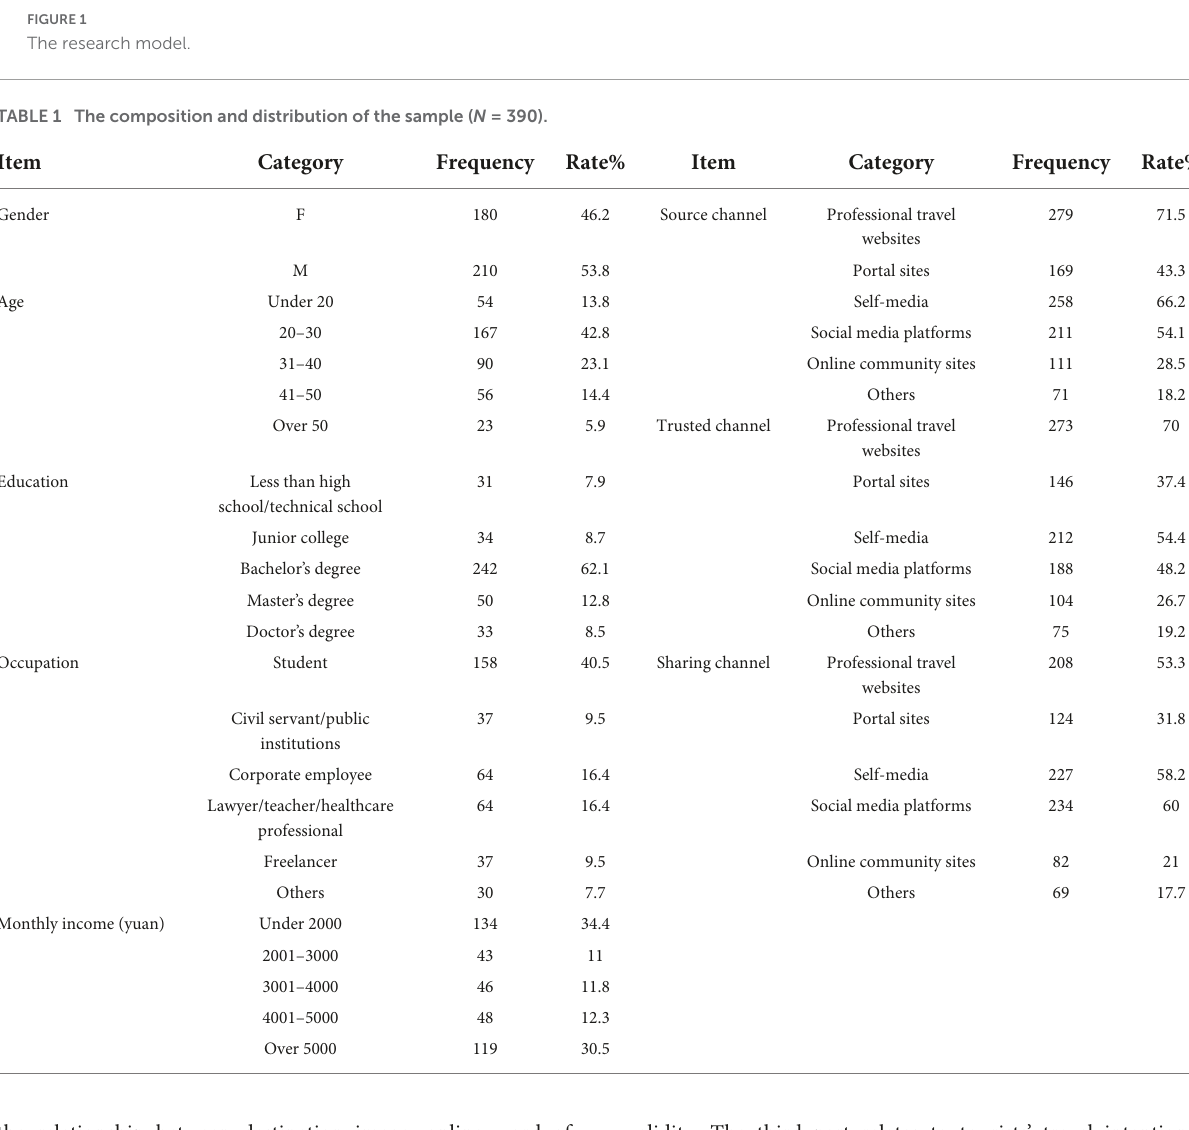
FIGURE1 The research model.